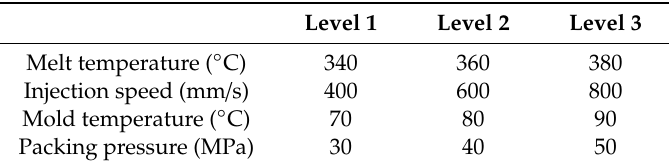
Table 3. Process conditions and levels for molding trial.